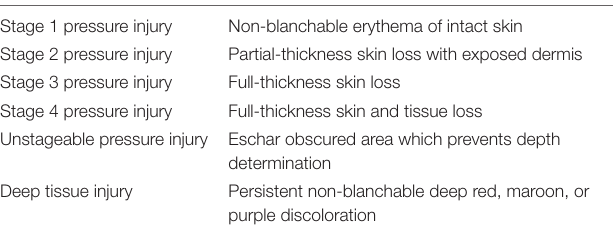
the assessment of different physiological mechanisms, e.g., TABLE 1 | National Pressure Injury Advisory Panel (NPIAP) classification